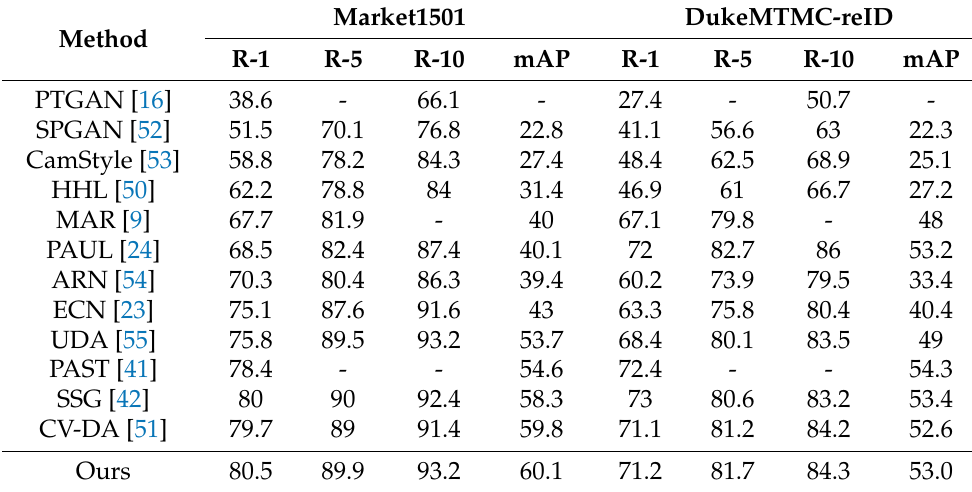
Table 3. Comparison with state-of-the-art cross-domain methods on Market-1501 and DukeMTMC- reID. The proposed method shows better accuracy on both